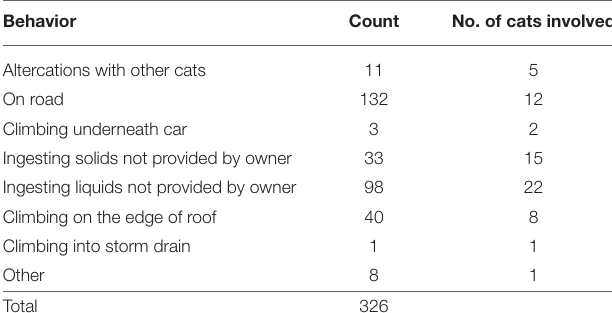
TABLE 6 | Risk behaviors displayed by study cats.